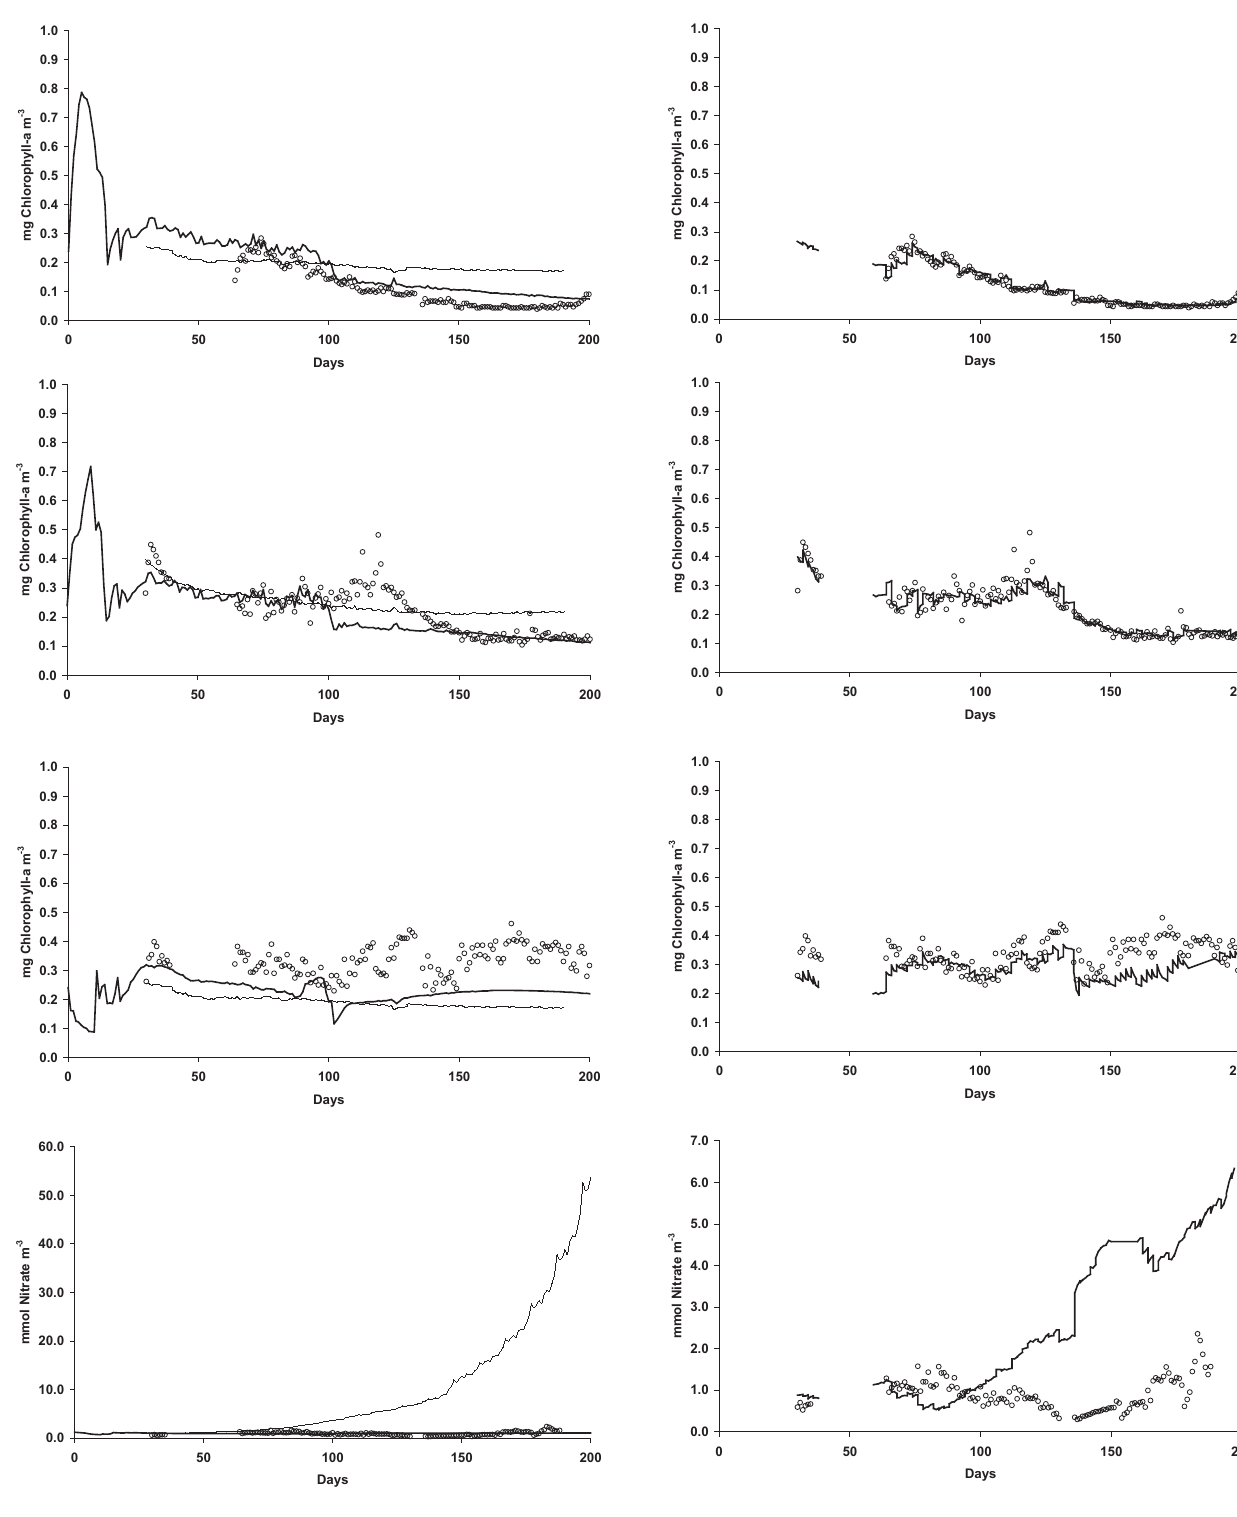
Fig. 6. EnKF estimate ( ) for assimilation of in situ chlorophyll-a every two days at (a) 40m, (b) 65m and (c) 115m and nitrate at 45m at the M3A site, along with data ( ◦